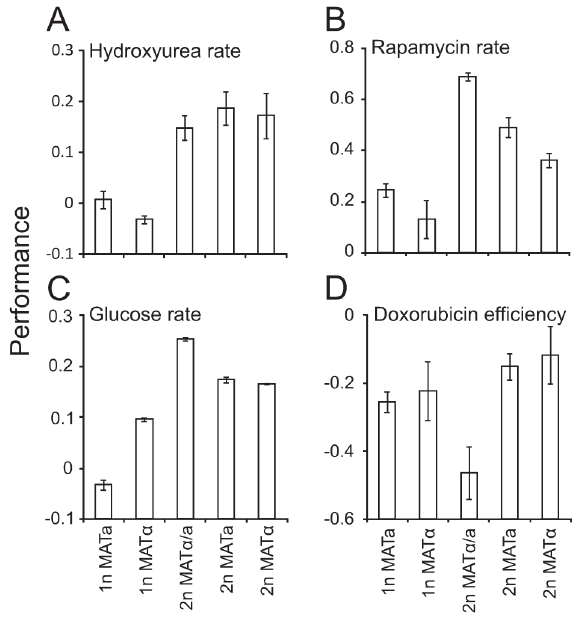
Figure 5. Mating type locus composition partially explains ploidy–environment interactions. Fitness component measures of S288c haploids, diploids heterozygotic, a / a , at the mating type locus and diploids hemizygotic, a or a , at the mating type locus, in various environments (n=4). A) Mitotic growth rate in hydroxyurea, a sample environment where mating type locus composition fails to explain fitness differences between haploids and diploids. Note that data is shown on a log(2) scale. B–D) Environments in which fitness differences between ploidy states are partially or completely explained by mating type locus compositions (FDR, a =0.05). Note that data is shown on a log(2) scale. B) Mitotic growth rate during rapamycin exposure C) Growth rate in nutrient excess and absence of stress D) Mitotic growth efficiency during doxorubicin exposure.